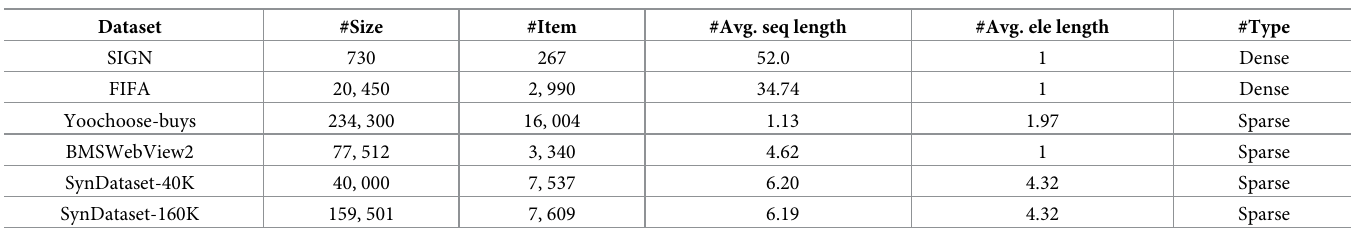
Table 4. Characteristics of the